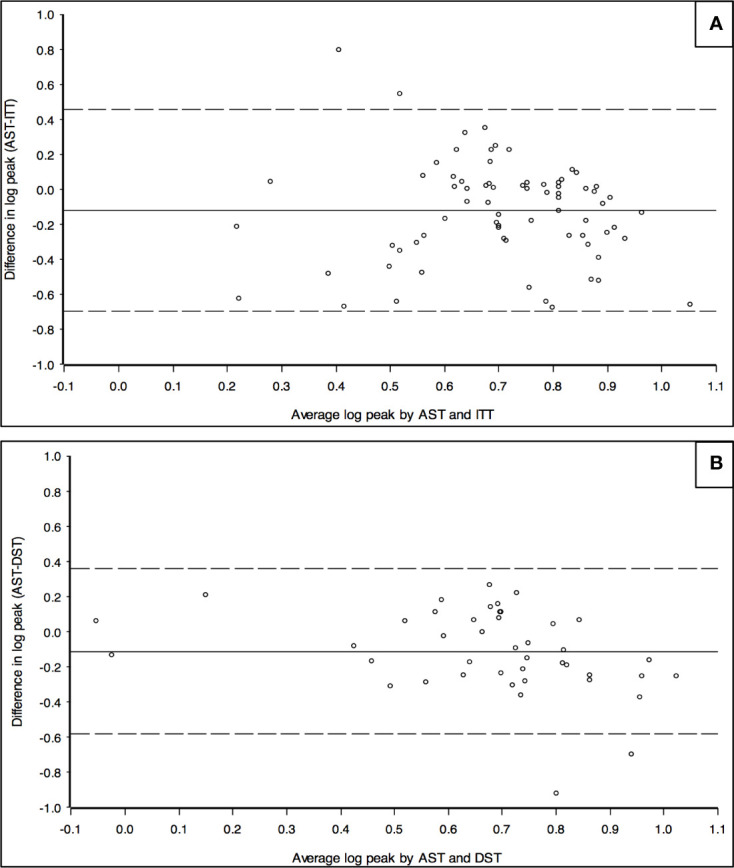
Bland-Altman chart to assess the agreement between GH peaks recorded after AST and ITT
(A) and between AST and DST
(B). Y axis: logarithm of the difference between the peaks of GH recorded in the same patient after AST and ITT
(A) or between AST and DST
(B). X axis: logarithm of the mean value of GH peaks recorded in the same patient after AST and ITT (A) or after AST and DST
(B). The chart represents the mean value of the difference between the two results recorded in each patient (solid horizontal line) and it is statistically lower than 0 in both Figures. Dotted horizontal line represent -2 and +2 SD.